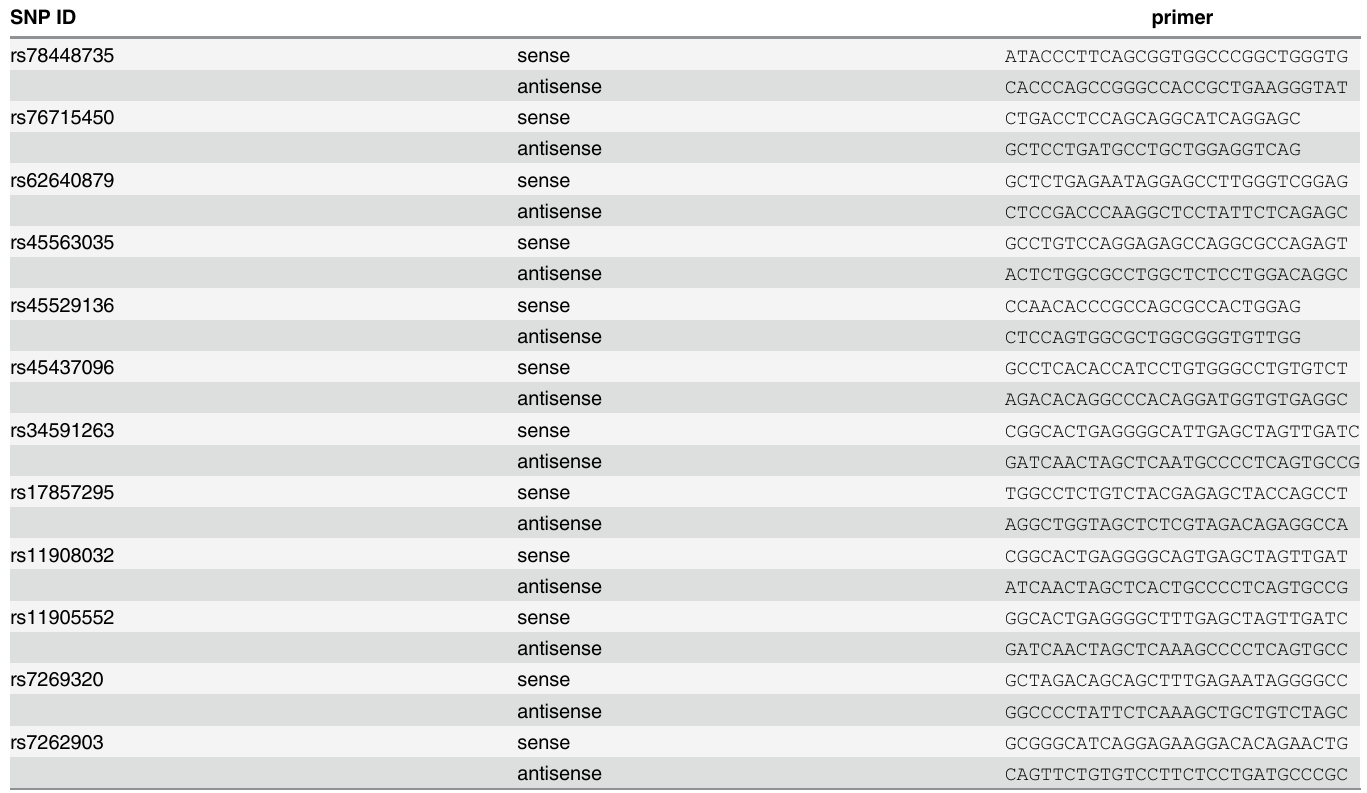
Table 1. Primer sets for the syntheses of